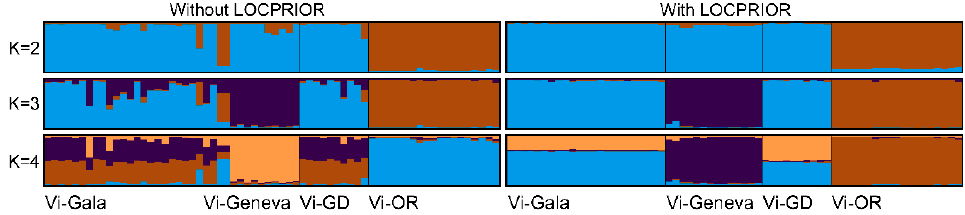
Figure 3. Structure bar plot showing ancestry coefficients of V. inaequalis isolates of four populations at K = 2 to 4, with and without adding the information on the sampling location (LOCPRIOR) to the model (different colors represent the different ancestral populations).